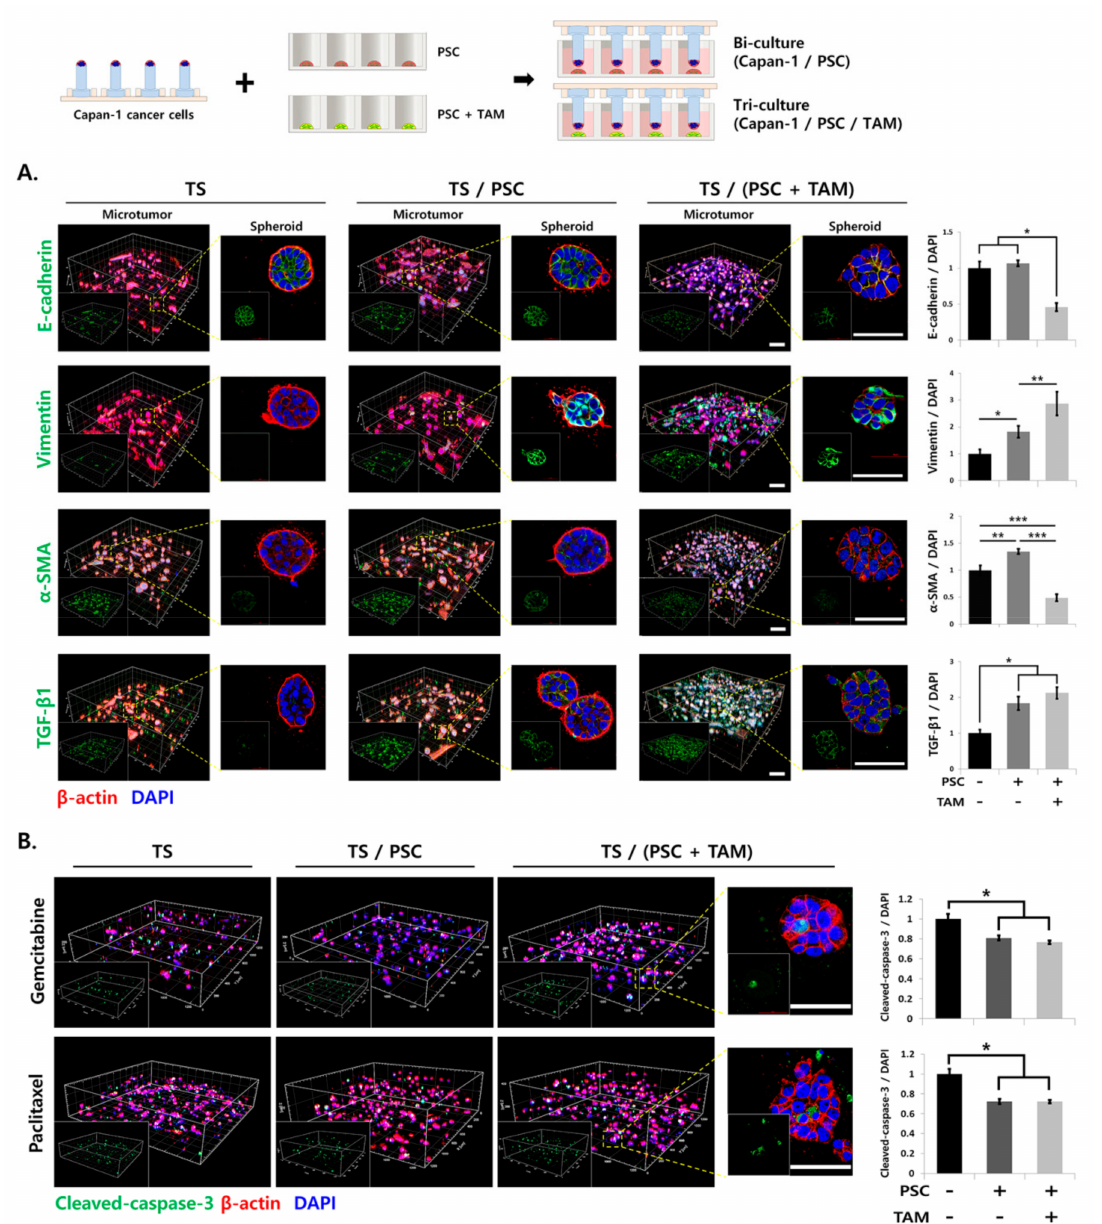
Figure 6. E ff ect of stromal cell co-culture on epithelial mesenchymal transition (EMT) and drug sensitivity of Capan-1 TSs. ( A ) Changes in the expression levels of EMT-related proteins in Capan-1 tumor spheroids (TS) under bi-culture (PSCs) or tri-culture (PSCs + tumor-associated macrophages (TAMs)) conditions. ( B ) E ff ect of stromal cell co-culture on drug-induced apoptosis in Capan-1 TSs. Confocal sections of microtumors were acquired at 3- µ m intervals and 3D images of a microtumor and an individual TS were reconstructed. Schematic illustration of the co-culture condition is shown at the top. The EMT-related markers (E-cadherin, vimentin, α -SMA, TGF- β 1) and apoptosis marker (cleaved-caspase-3) are shown in green, β -actin is shown in red, and DAPI is in blue. Data represent the mean ± SD of three independent experiments. Scale bars: 50 µ m. * p < 0.05, ** p < 0.01, *** p < 0.001. TS: tumor spheroid; PSC, pancreatic stellate cell; TAM, tumor-associated macrophage; α -SMA, alpha-smooth muscle actin; TGF- β 1, transforming growth